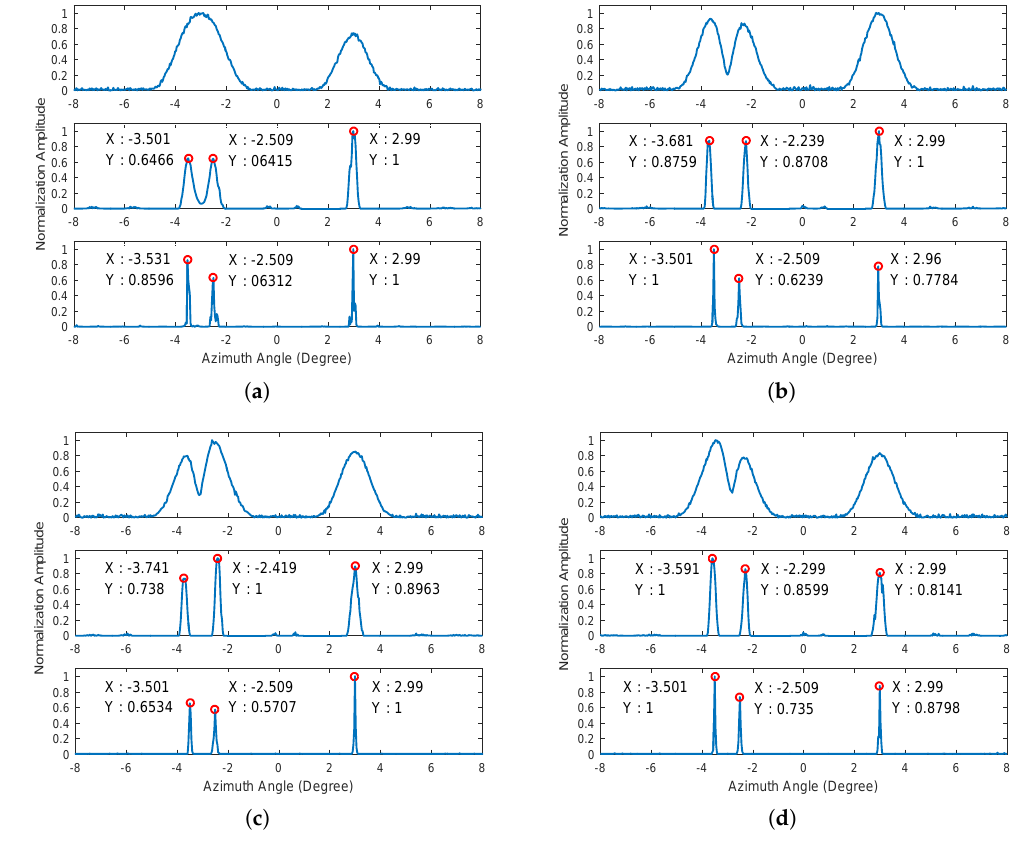
Figure 2. Simulation results of point target when the signal-to-noise ratio (SNR) is 25 dB. The top subfigure is the cross-range received signal after motion compensation; the middle subfigure is the superresolution result processed by the Poisson-based maximum a posteriori (MAP) algorithm; and the bottom subfigure is result processed by the proposed sparse Bayesian algorithm. ( a ) Platform velocity is 0 m/s; ( b ) platform velocity is 100 m/s; ( c ) platform velocity is 200 m/s; ( d ) platform velocity is 300